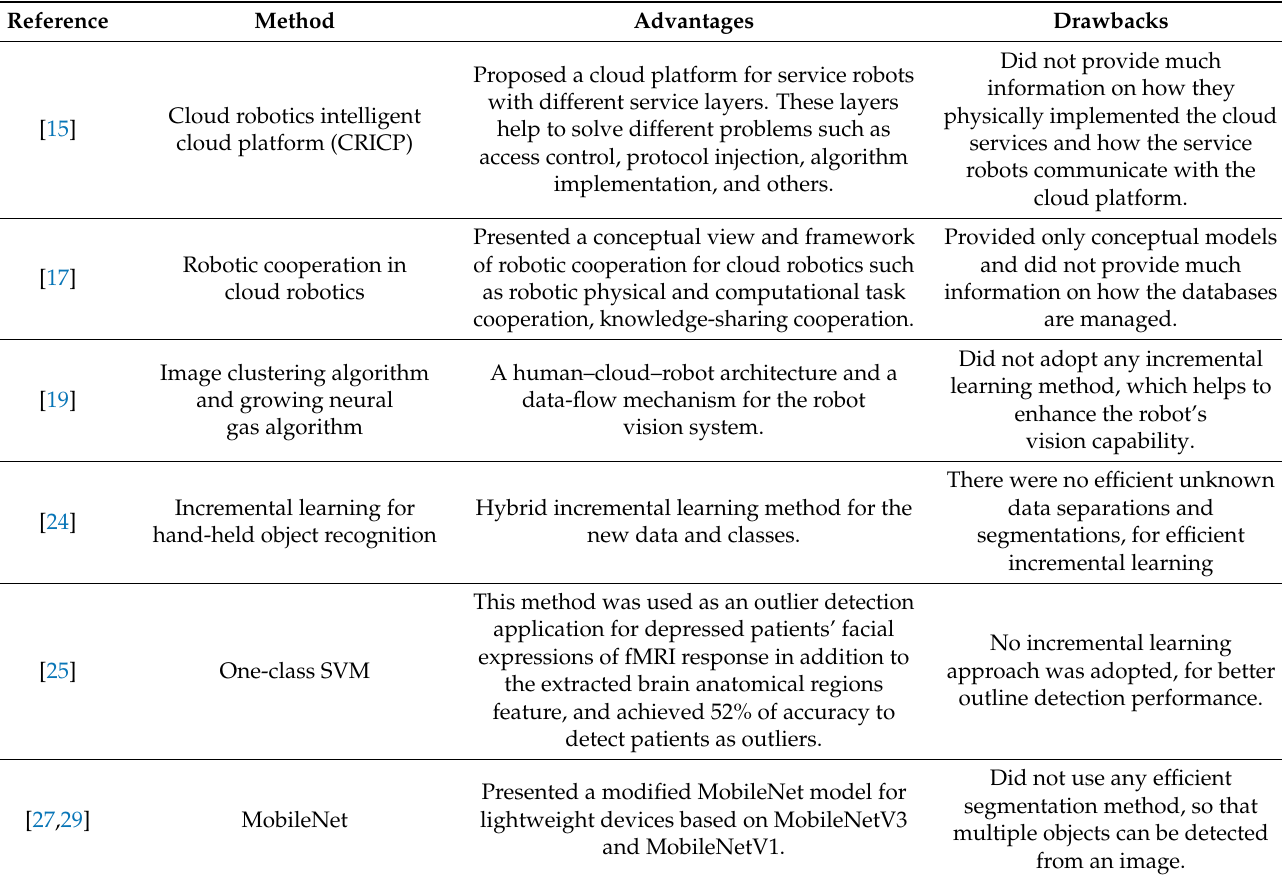
Table 1. Summary of state-of-the-art methods, including their advantages and